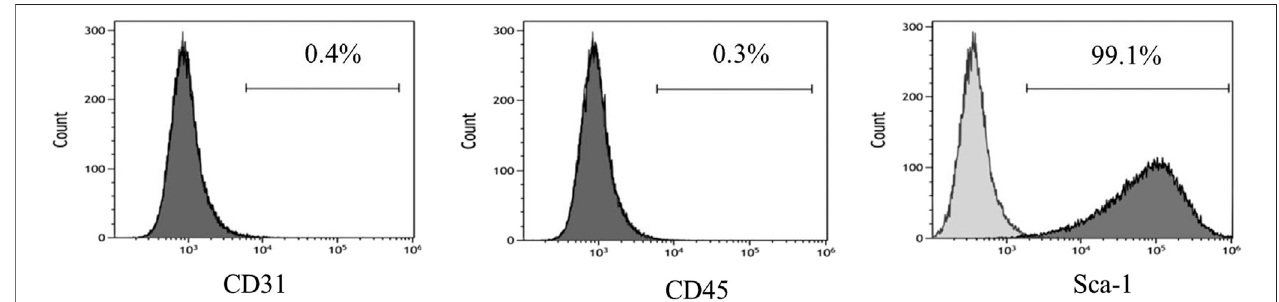
FIGURE 3 | MSCs surface molecules detected by fl ow cytometry after infection by control adenovirus. n (cid:2) 3 per group.